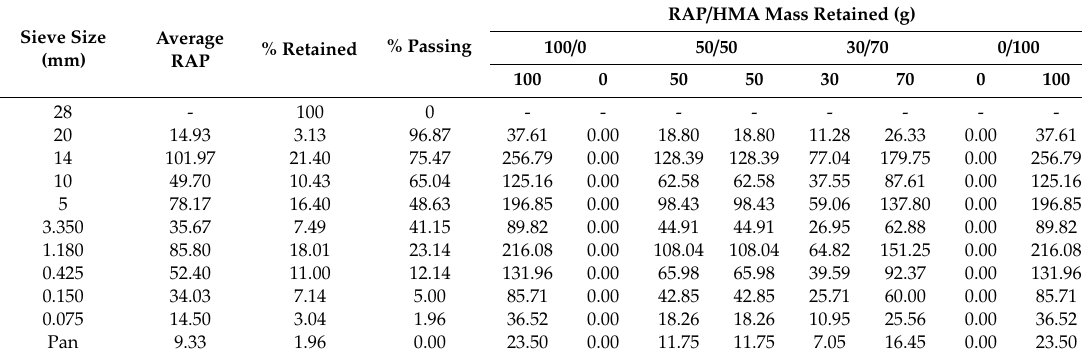
Table 3. Composition of RAP variation containing in HMA mix.